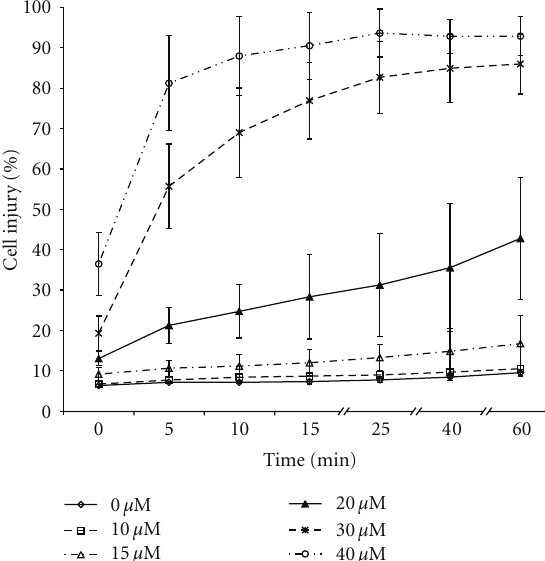
Figure 3: Dose and time dependence of lymphocyte injury with exposure to various concentrations of AlCl 3 (0–40 µ M) at various time points. Other conditions were as described in the legend to Figure 2. All concentration curves are significantly di ff erent from each other at the P < . 05 level by ANOVA with the exception of 0 and 10 minutes. There were no significant changes with time between 25, 40, and 60 minutes, nor between 10 and 15 minutes, but all other time periods were significantly di ff erent at the P < . 05 level by